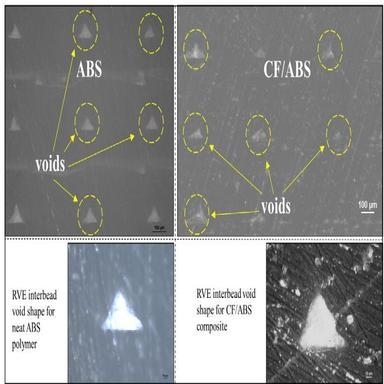
No text of specified style in document.. Microstructure of neat ABS and CF/ABS parts fabricated by the FFF process.